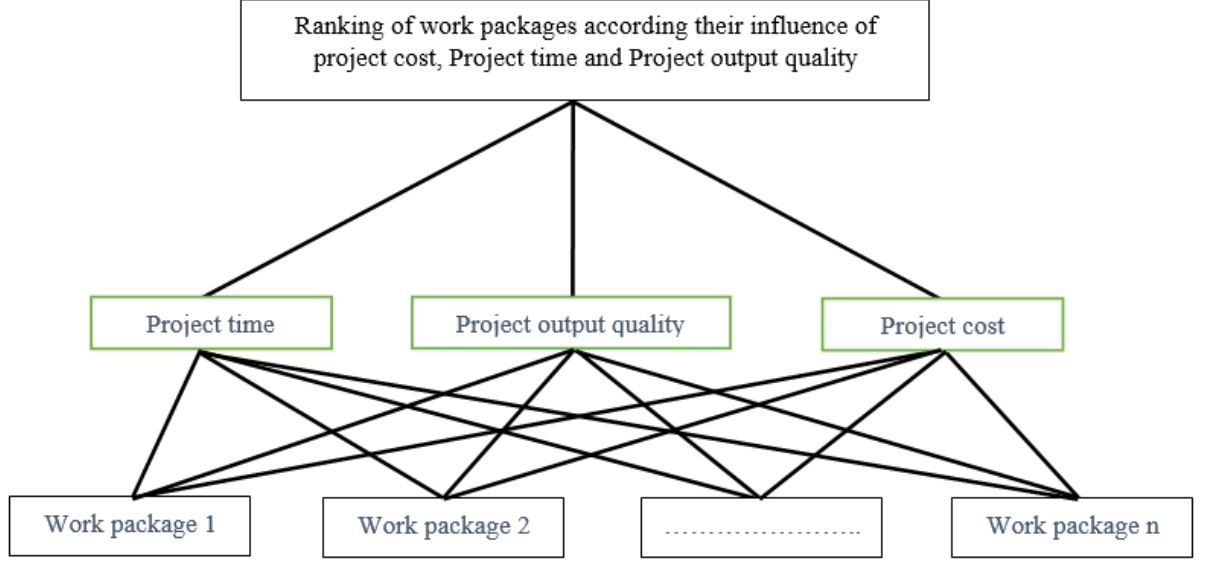
Figure 1. AHP model of work package prioritization process.